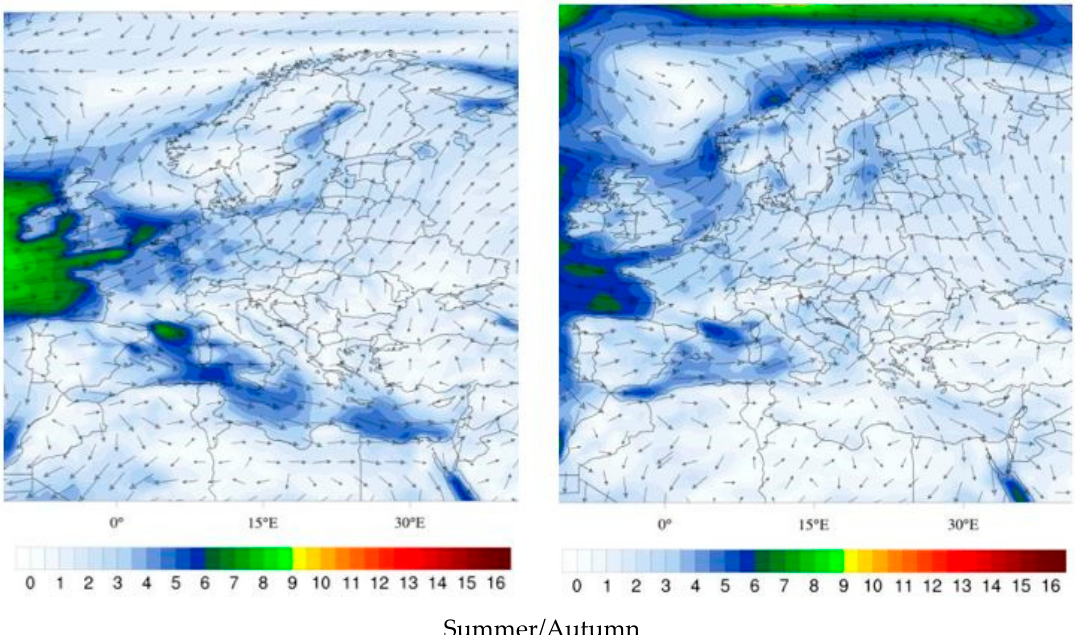
Figure 6. Map of the Mediterranean Sea winds at 10 m, units in m/s. Referring to the Nile/Tel Aviv-Gaza System. Source: [50].